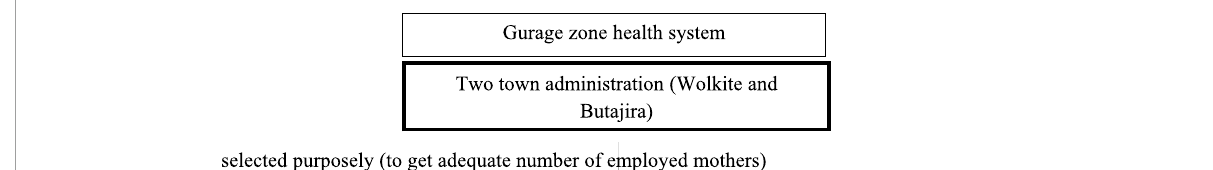
FIGURE1 Schematic presentation of the sampling procedure for a study on the relationship between maternal employment and stunting among 6–59-month-old children in Gurage Zone SNNPR, Ethiopia 2021.